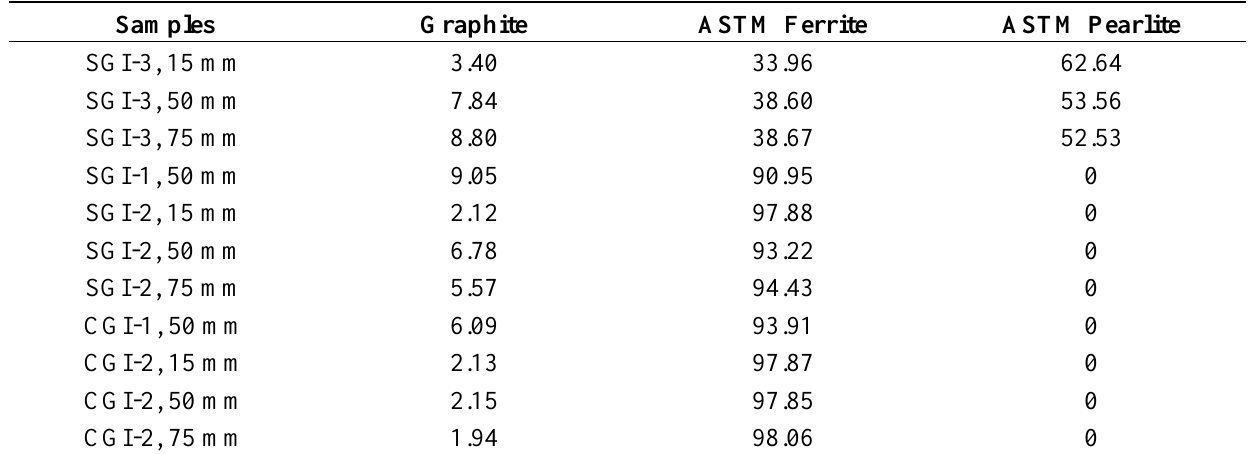
Table 3. Graphite and ferrite/perlite area fractions (%).